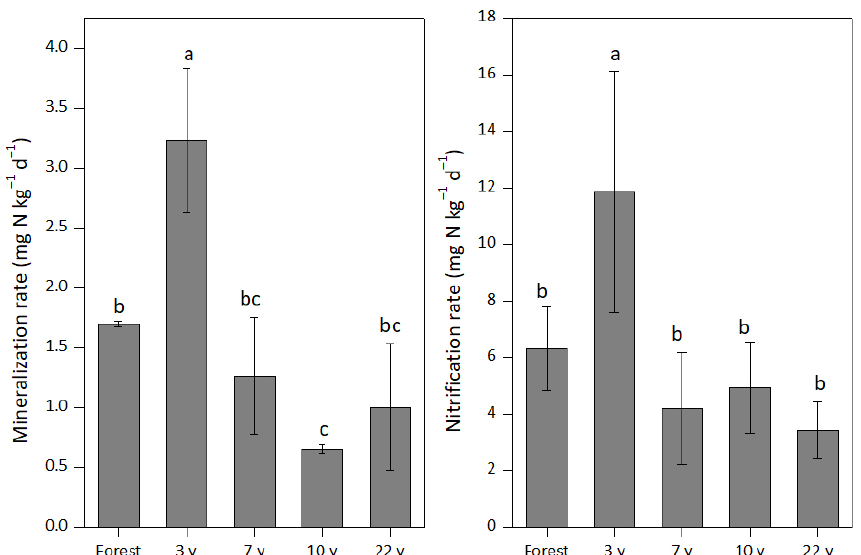
Figure 2. M Norg and O NH4 rates in soils under natural forest conditions and in banana plantations with different cultivation durations. Identical letters for M Norg and O NH4 indicate there were no significant differences in soils under natural forest conditions and in the four banana plantations in the same region, at p = 0.05. M Norg , the mineralization of organic N to NH 4+ ; O NH4 , the oxidation of NH 4+ to NO 3 − .